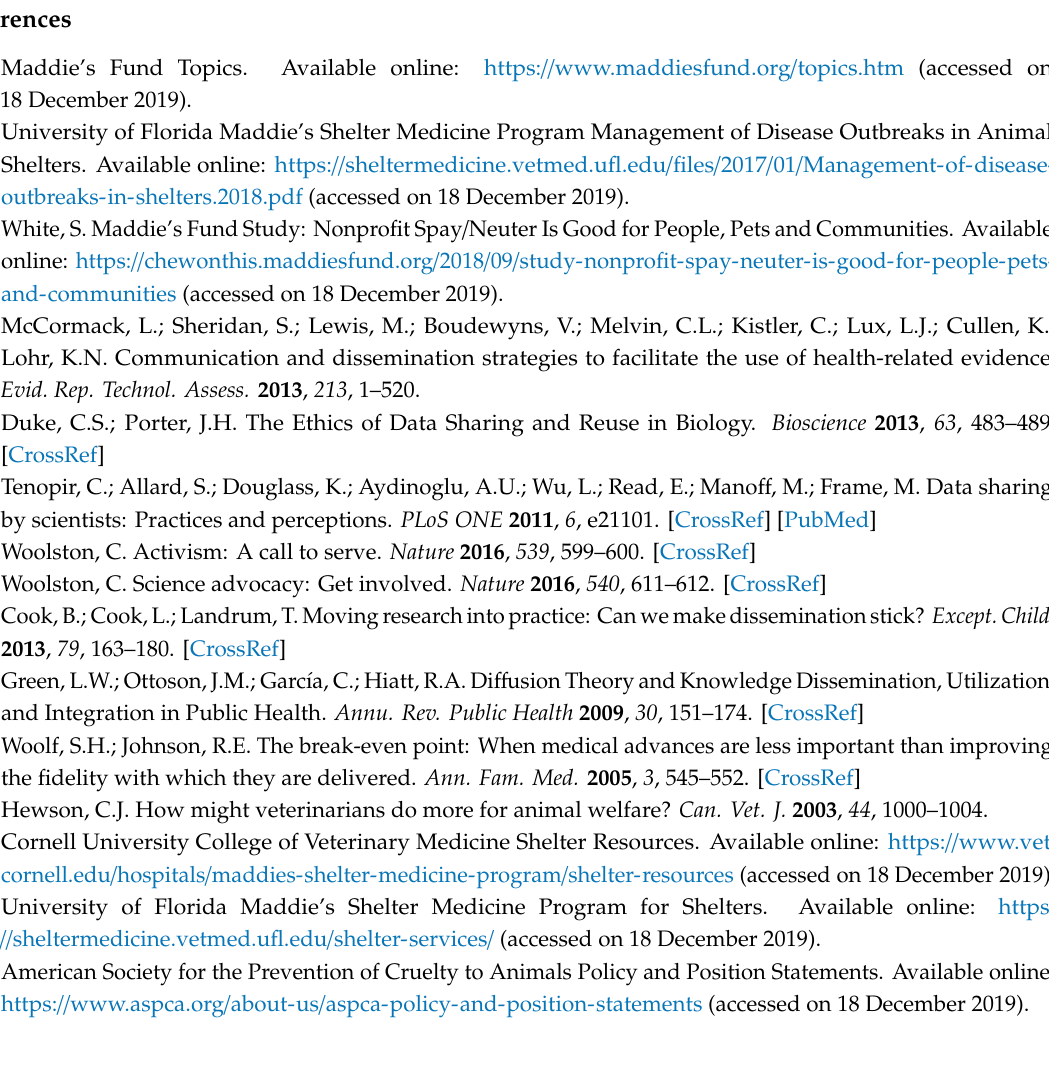
Figure S1: A provided poster asked shelter visitors to operate the remote data collection device following a meet-and-greet, Figure S2: A provided “cheat sheet” for the animal shelters to remember the key features of the meet-and-greet intervention, Figure S3: The face and electrical diagram of the remote data collection